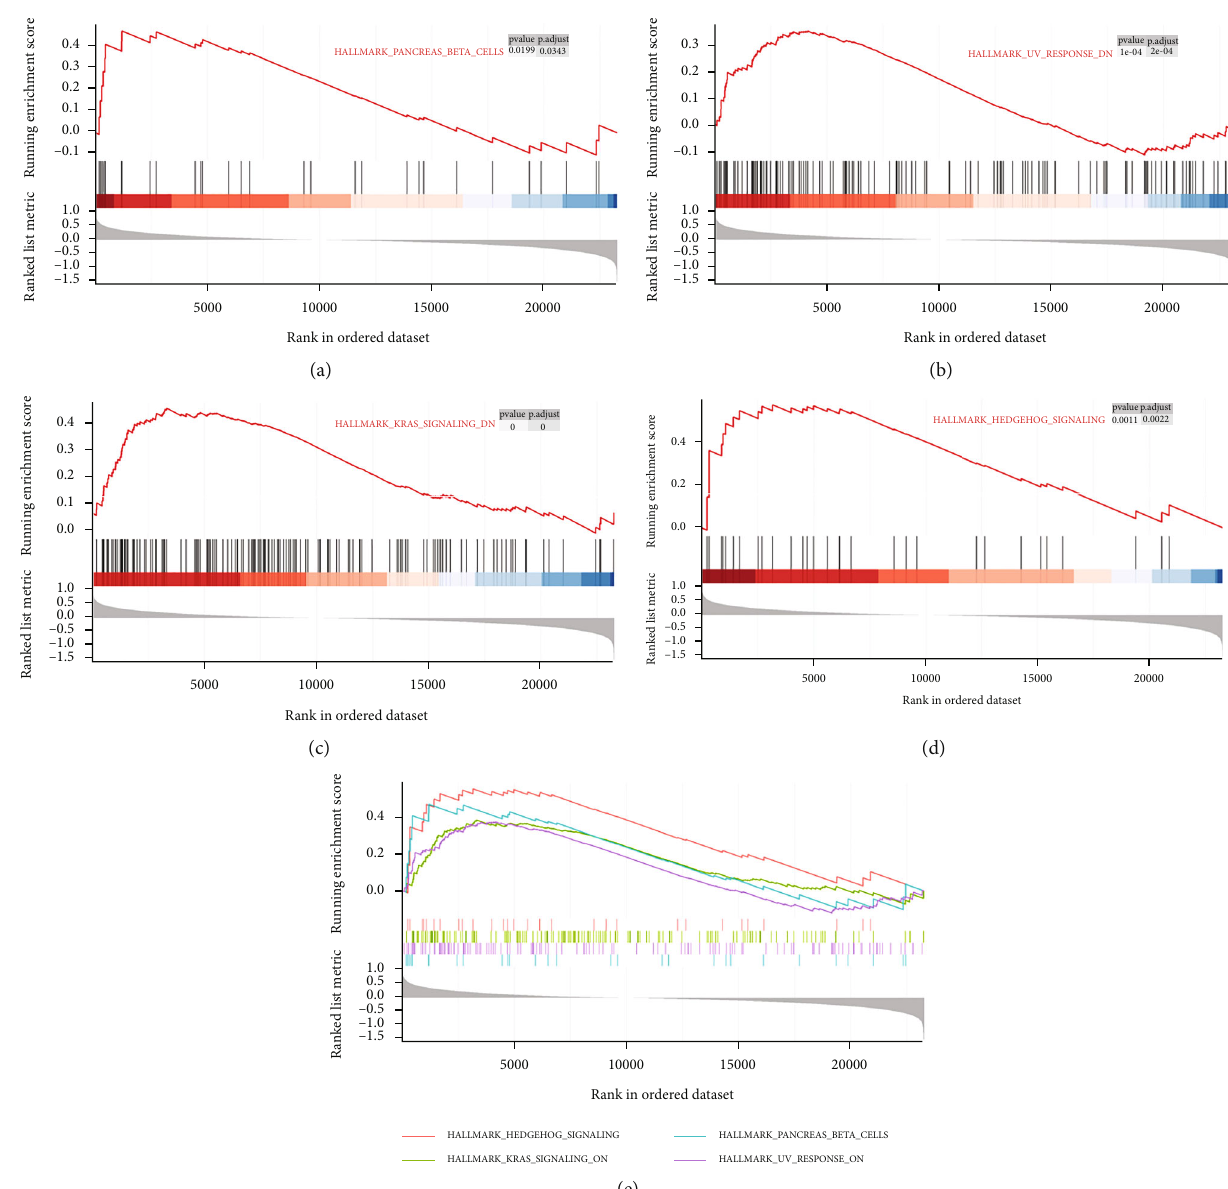
Figure 6: High GPX8 expression is signi fi cantly correlated with (a) pancreas beta pathway, (b) UV response, (c) kras signaling, (d) hedgehog signaling pathway, and (e) merged four